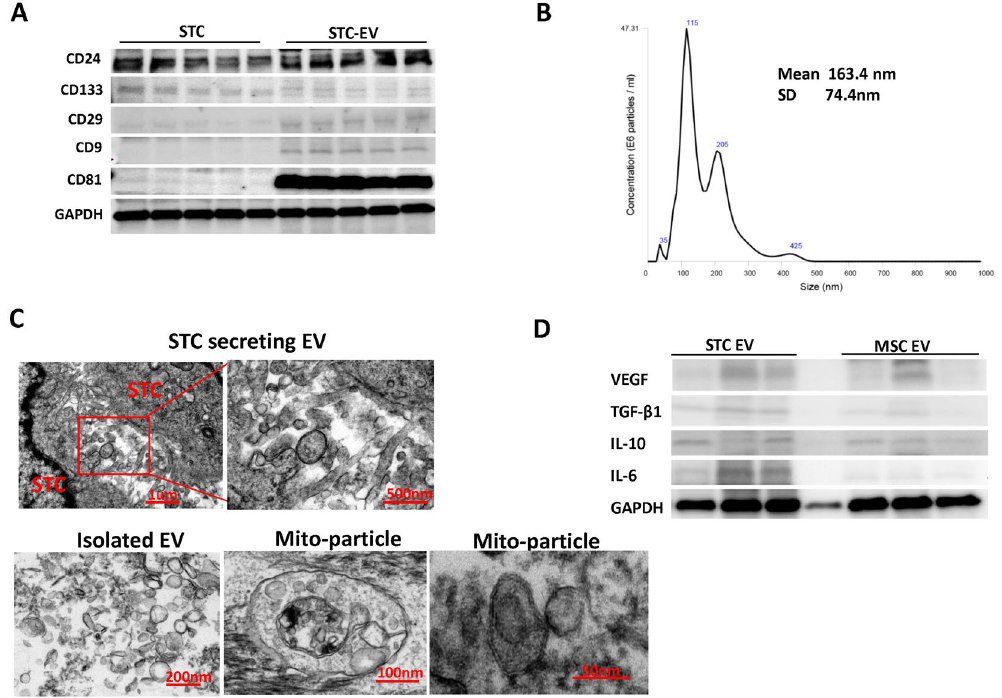
Figure 2. Characterization of scattered tubular cells (STC-like cells) derived extracellular vesicles (EV). ( A ) Western Blot analysis showed that the EV were positive for CD24, CD133, CD9, CD29 and CD81. ( B ) Nano-Sight analysis of purified EV to assess the size distribution of EV. ( C )Transmission electron microscopy of cultured STC-like cells showed EV shedding from the cell surface, and in purified EV confirmed their spheroid shape and the presence of mitochondria packed-particles. ( D ) Western Blot analysis showed that STC-like cells EV express similar proteins to MSC EV, but more TGF- β 1 and